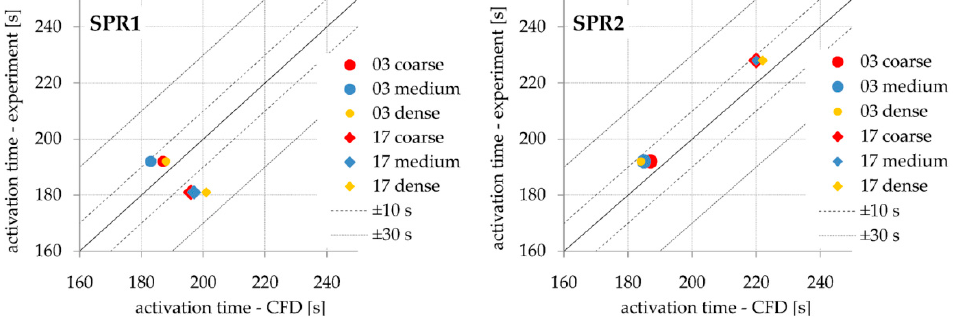
Figure 2. Comparison of sprinkler activation times for different meshes for experiments #03 and #17.